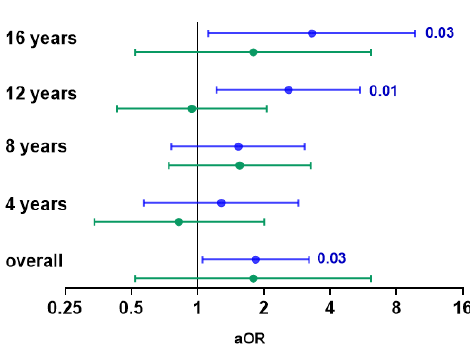
Figure 1. Adjusted associations of high IgE levels in children with Der p 1 levels in human milk and infant’s mattress dust. Adjusted odds ratios (aORs) for high levels of IgE (top tertile, > 150 kU/L) at 4–16 years of age in children exposed to detectable versus non-detectable Der p 1 in human milk (blue circles) and in infant’s mattress dust (green circles). ORs were adjusted for child’s age at the time of reporting asthma and maternal asthma, as well as for maternal allergy to house dust mites, sex, and pets in the child’s home during the first year of life.